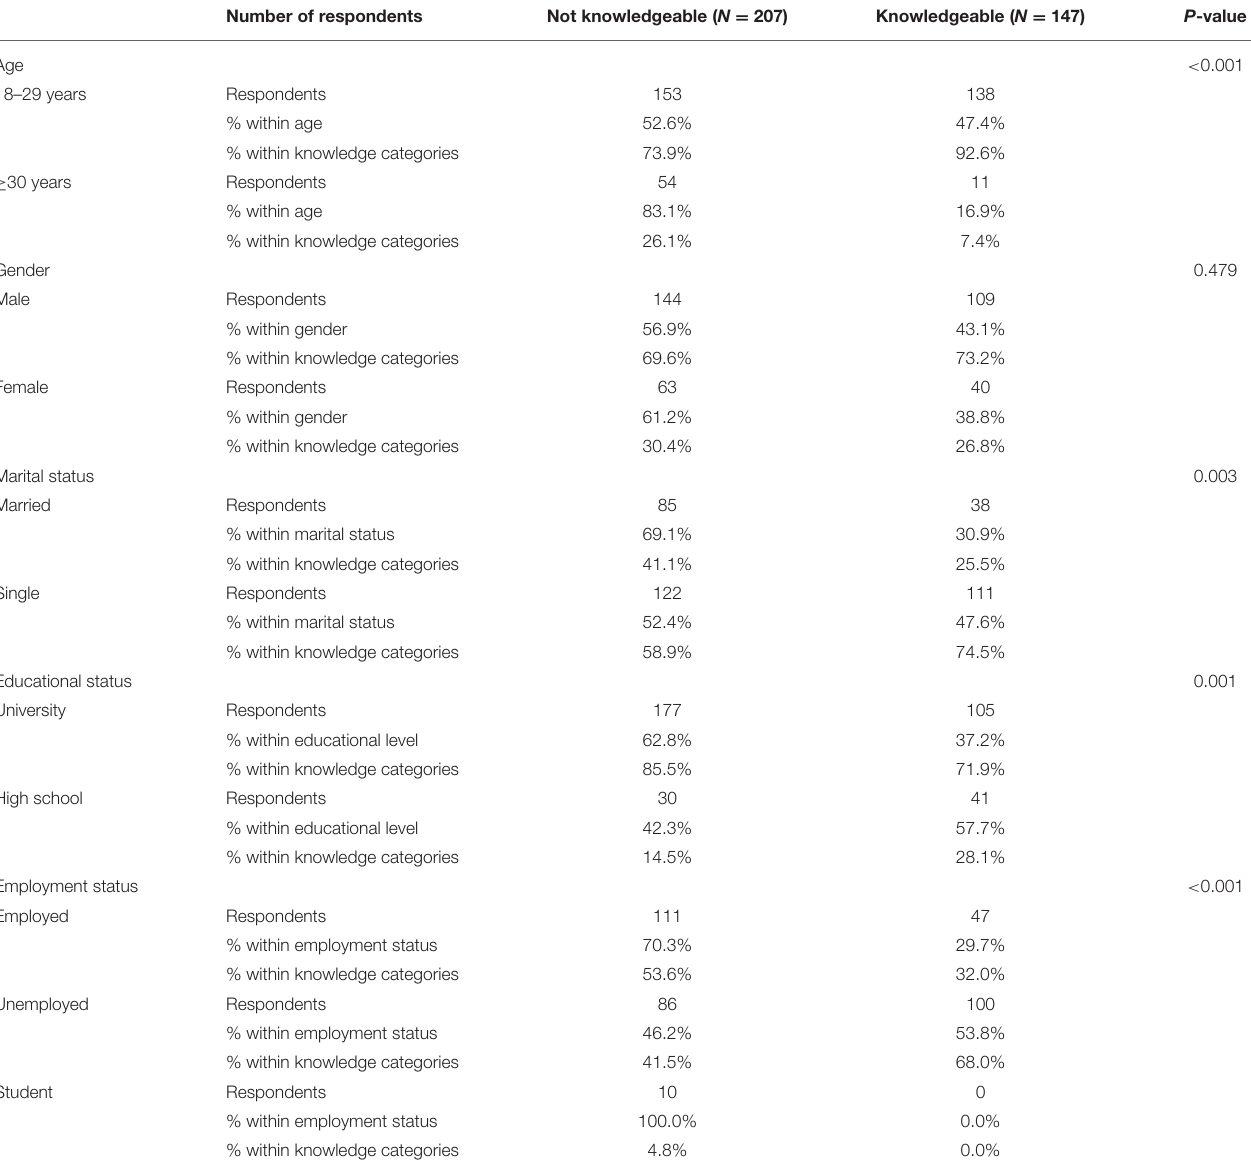
TABLE 6 | Cross-tabulation between demographic characteristics and knowledge categories. Number of respondents Not knowledgeable ( N =